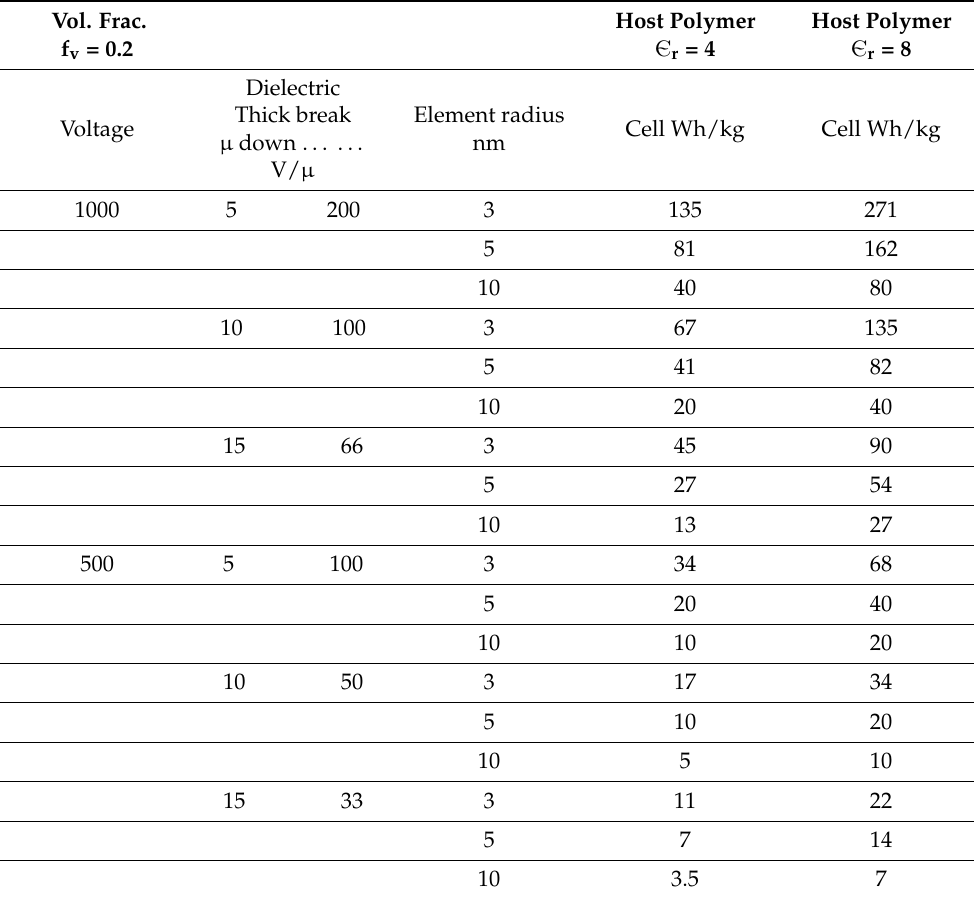
Table 3. Dielectric cell Wh/L using spherical carbon elements and host polymer. Vol.